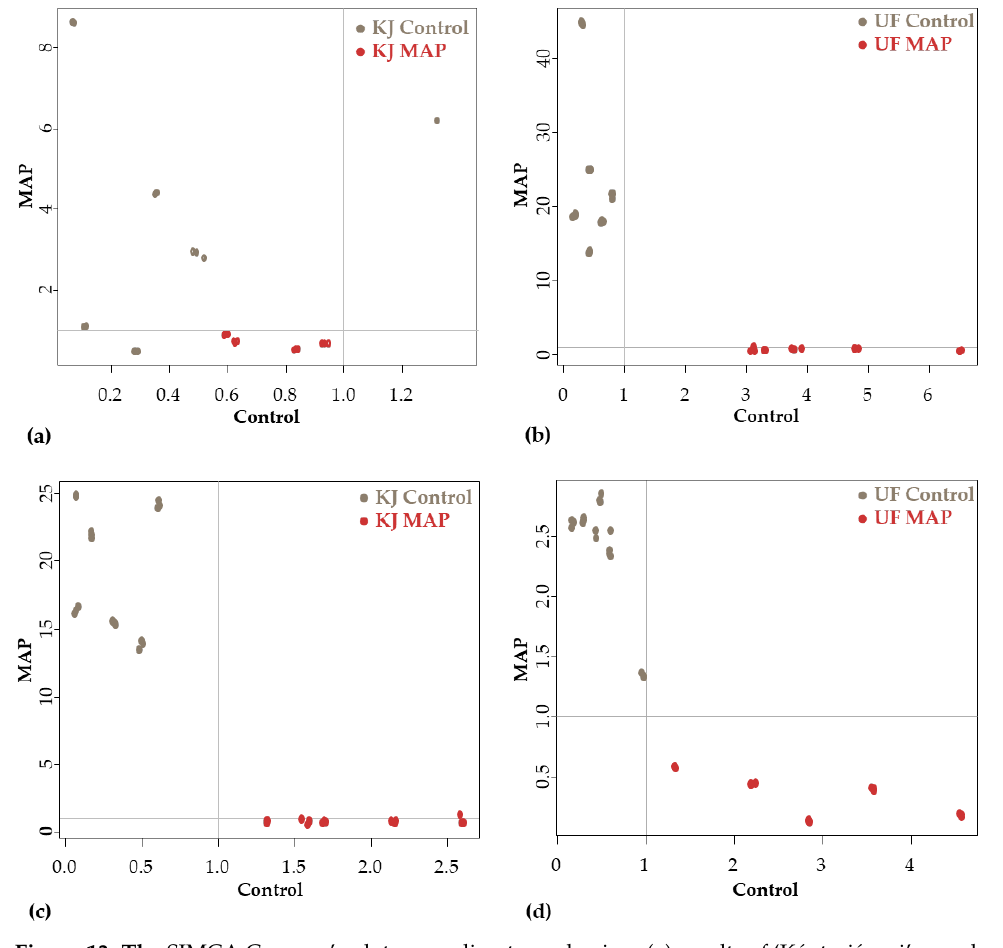
Figure 13. The SIMCA Cooman’s plots according to packaging: ( a ) results of ‘Kántorjánosi’ samples on day 1 ( n = 28, k = 2); ( b ) results of ‘Újfehértói fürtös’ samples on day 1 ( n = 33, k = 4); ( c ) results of ‘Kántorjánosi’ samples on day 10 ( n = 33, k = 4); ( d ) results of ‘Újfehértói fürtös’ samples on day 10 ( n = 33, k = 3).